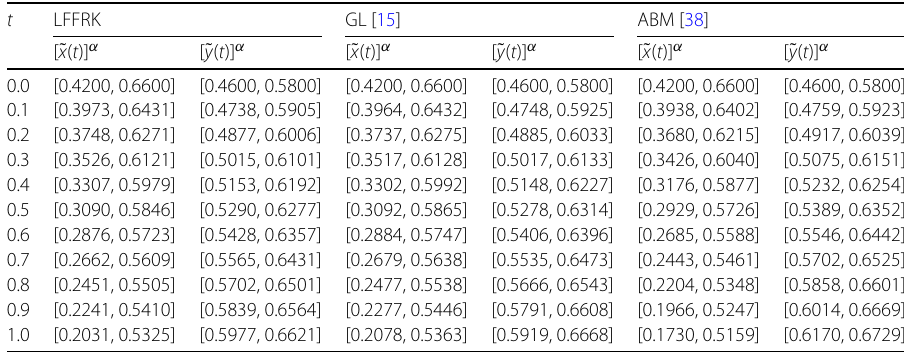
Table 4 Solutions of system (14) with the comparison to GL and ABM for σ = 0.95, α = 0.6